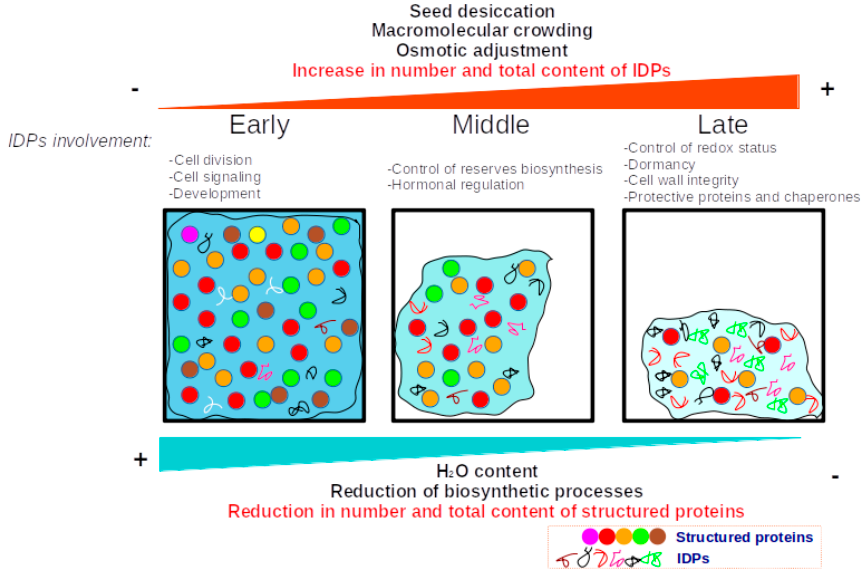
Figure 8. Proposed model of disorder adjustment in the development of orthodox seeds. At the beginning of the development of the seed, the biosynthesis of the reserve compounds and the molecules required to grow and develop is active, the available water is abundant, and the content of structured proteins is high (A). As the development program progresses, there is a significant reduction in water content, cell volume is reduced, and macromolecular crowding increases. This e ff ect causes unwanted interactions between proteins, loss of tertiary structure, and protein aggregation. To reduce this negative e ff ect, cells activate protective mechanisms (such as the biosynthesis of compatible solutes and the induction of chaperones). However, we propose that there is also a sharp reduction of the most labile proteins, without the replacement of other types of structured proteins. In contrast, the content of the IDPs increases and all the genes expressed de novo encodes for IDPs (B). The number of structural proteins continues to decrease, as does their content. It is considered that all this complements the typical mechanisms of tolerance to desiccation. In general, this can be considered to be a strategy to make the proteome more resilient to water-limiting conditions by a mechanism mediated by overall adjustment of the protein